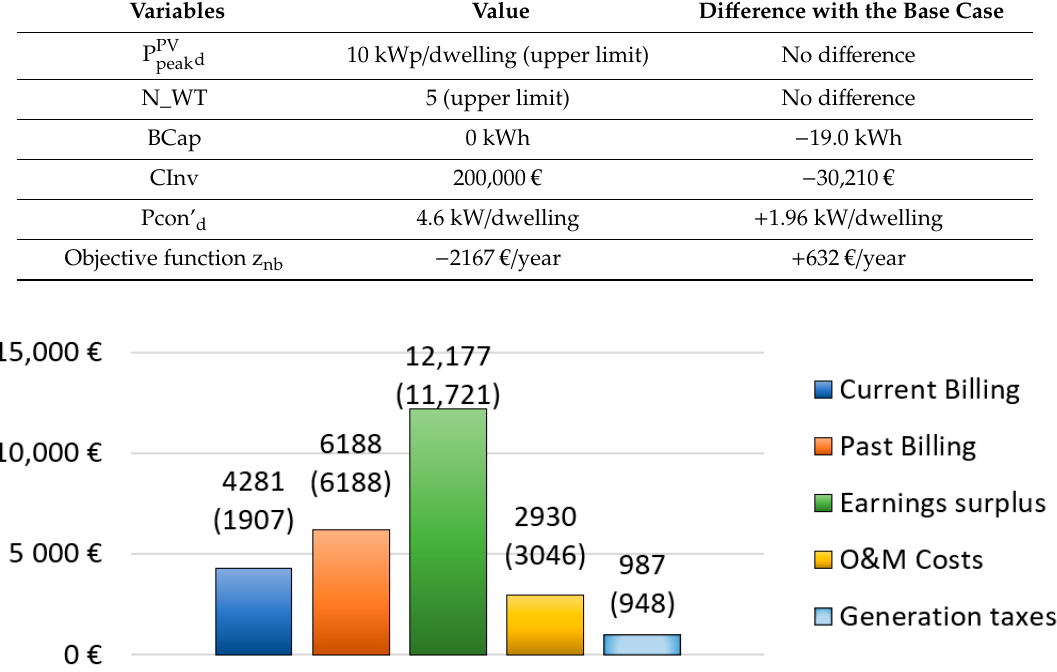
Figure 14. Breakdown of the averaged annualized costs and earnings in the second stage for the energy community without energy storage. In parenthesis, the second stage costs for the model with energy storage. Source: self-elaboration.